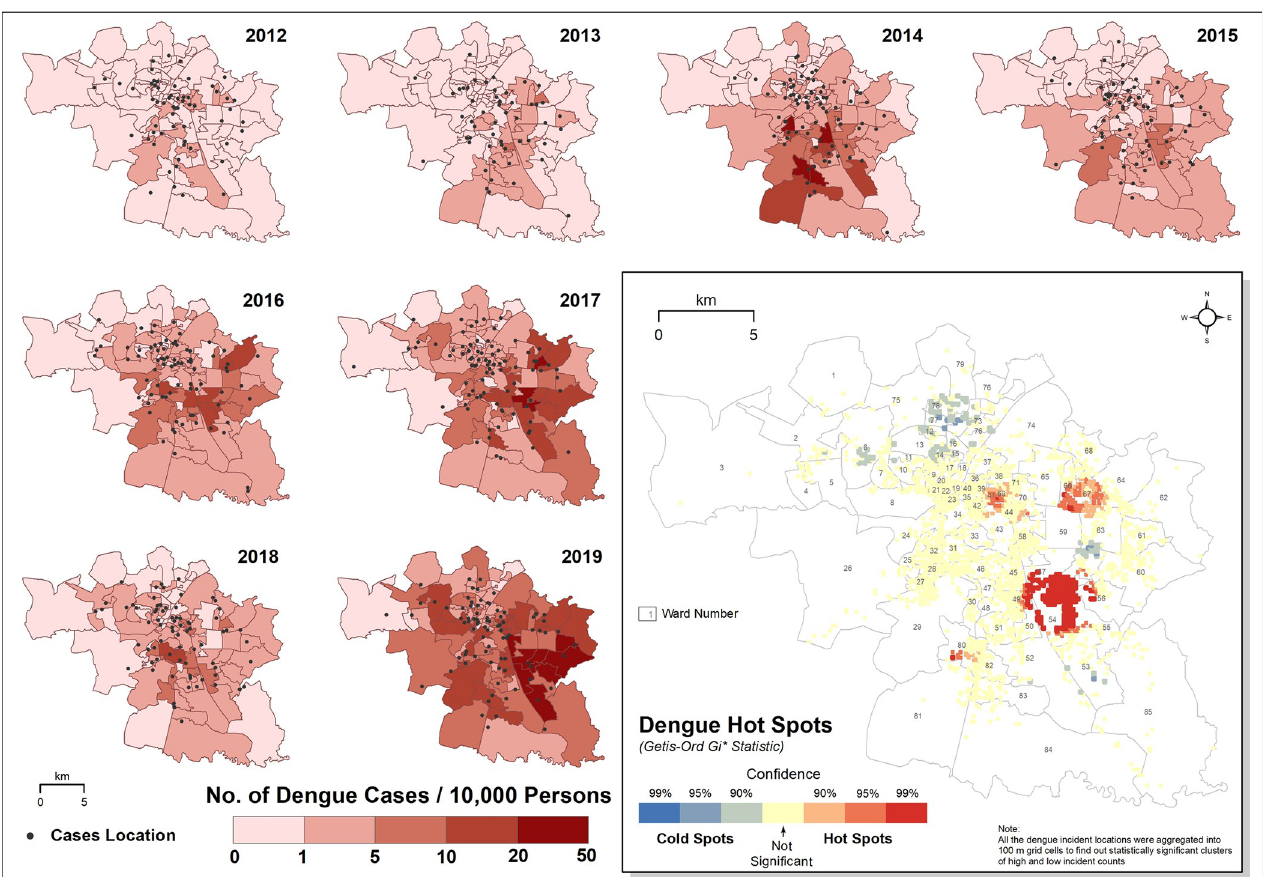
Fig 3. Ward wise spatial distribution of dengue cases (2012–2019) indicating significant hotspots and coldspots in Bhopal city. The hotspots are shown in the map as shades of red to highlight the geographic areas where the clustering of dengue cases occurred. Similarly, coldspots with negative Z-scores are shown in blue to indicate areas where fewer-than-expected dengue cases were observed. (Source of shapefile: